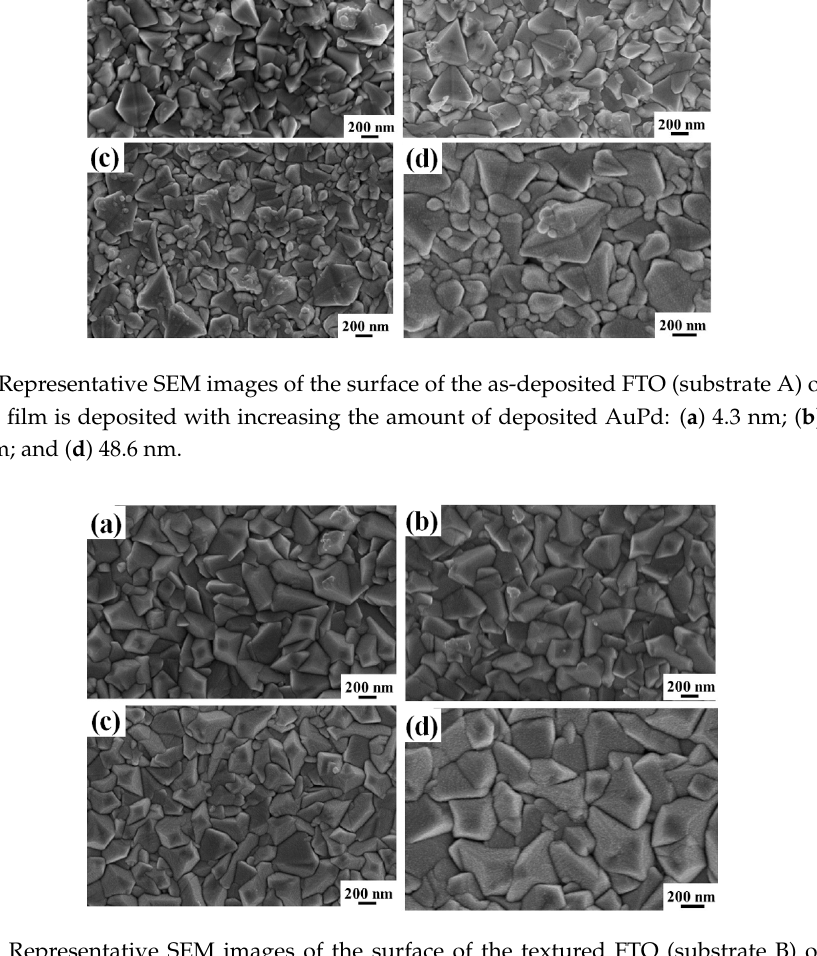
Figure 4. Representative SEM images of the surface of the textured FTO (substrate B) on which the AuPd film is deposited with increasing the amount of deposited AuPd: ( a ) 4.3 nm; ( b ) 7.5 nm; ( c ) 29.2 nm; and ( d ) 48.6 nm.